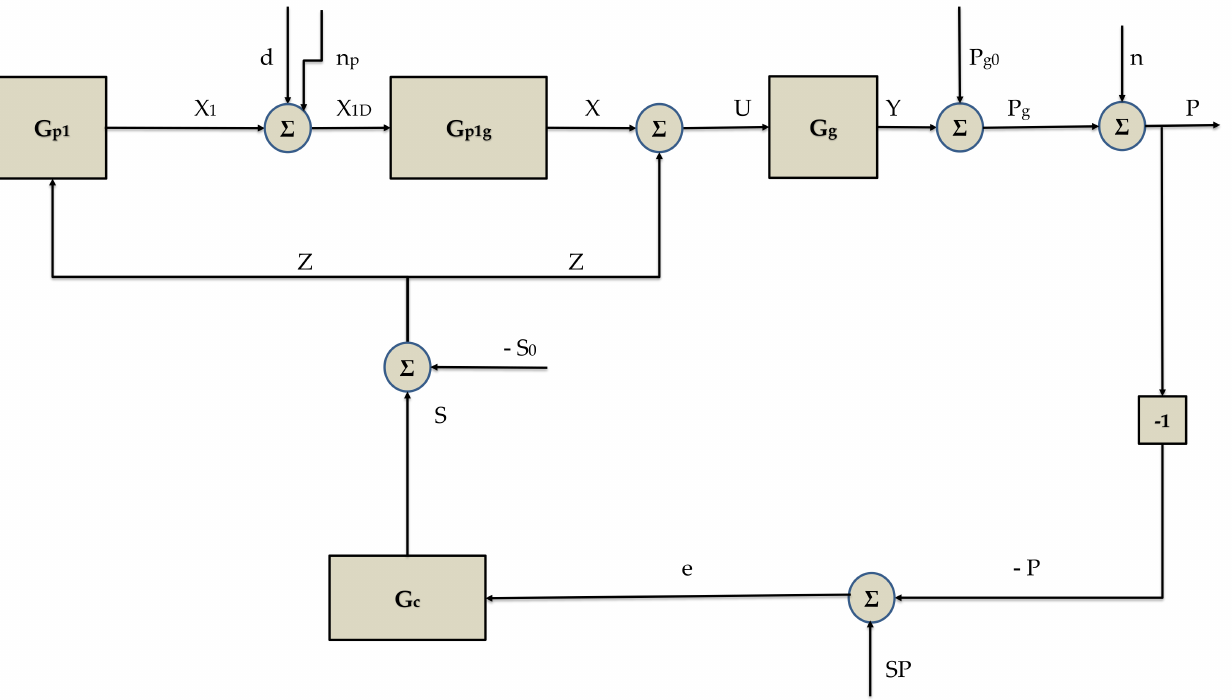
Figure 3. Feedback control